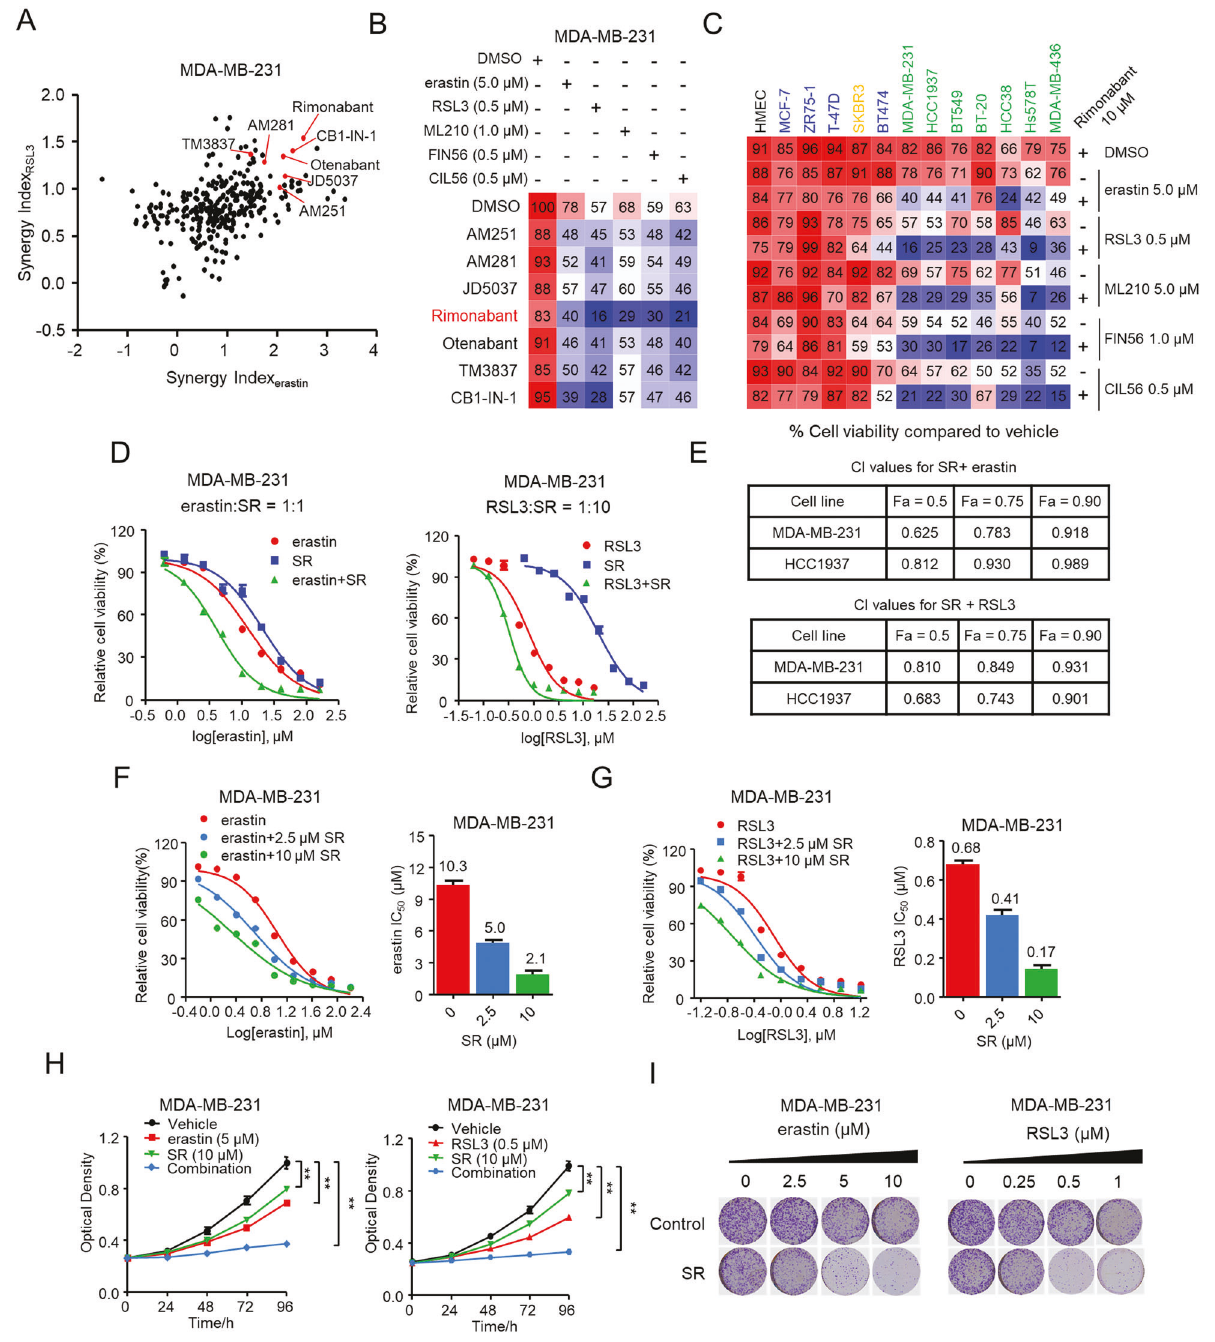
Fig. S4A, antioxidant Ferrostatin-1, GSH, and the iron chelator Deferoxamine, which are known to inhibit ferroptosis [25], could effectively reversed the effect of rimonabant + erastin and rimonabant + RSL3 on reducing cell viability. In contrast, the apoptosis inhibitor Z-VAD-FMK, necrosis inhibitor Necrostatin-1 as well as autophagic cell death inhibitor 3-methyladenine (3MA), respectively, only marginally rescued cell death in response to combinational treatment. Then we investigated the combinational effect on ferroptosis characteristics including the level of lipid peroxidation, MDA, 4- HNE, cytosolic ROS level promotion and GSH depletion in